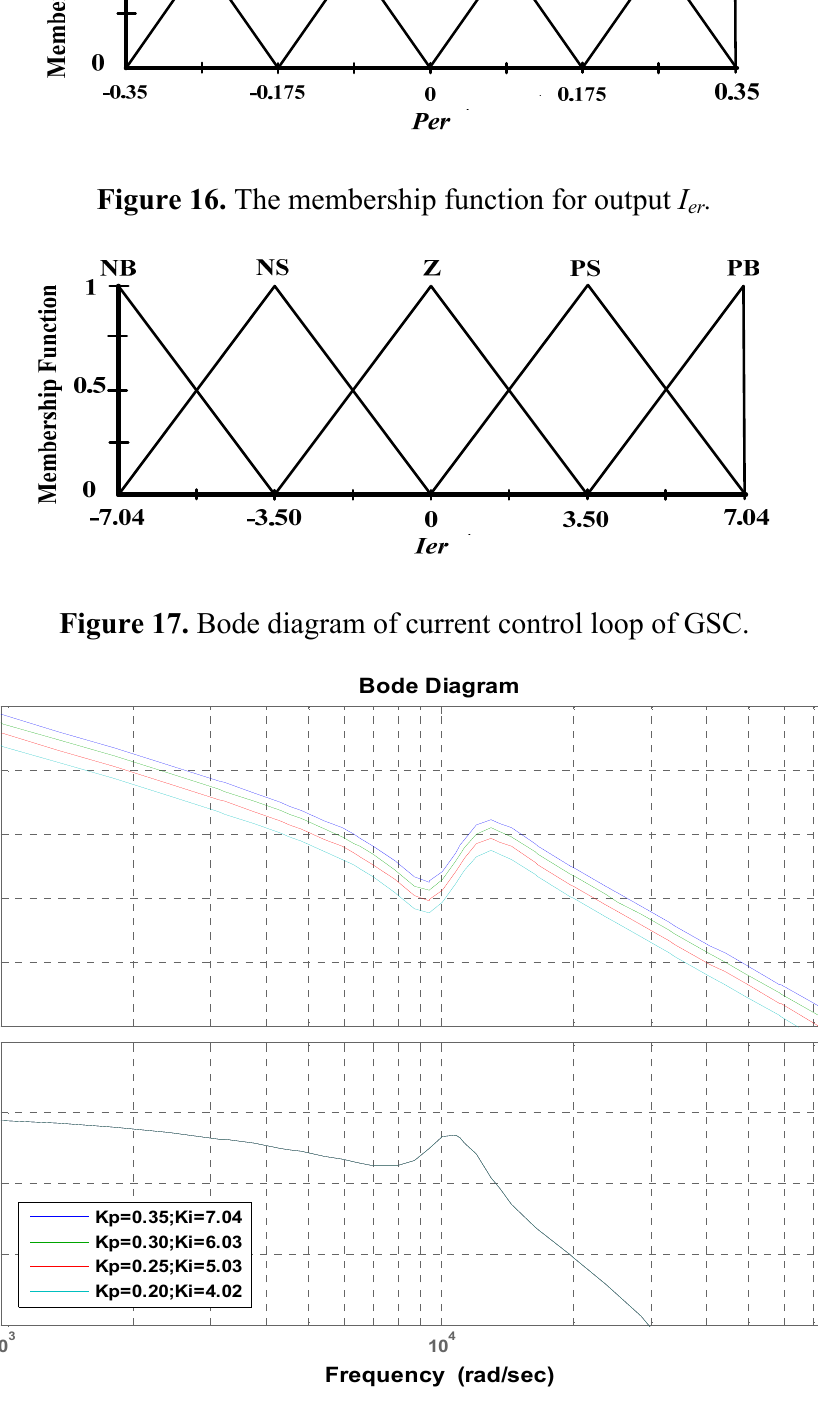
Figure 16. The membership function for output I